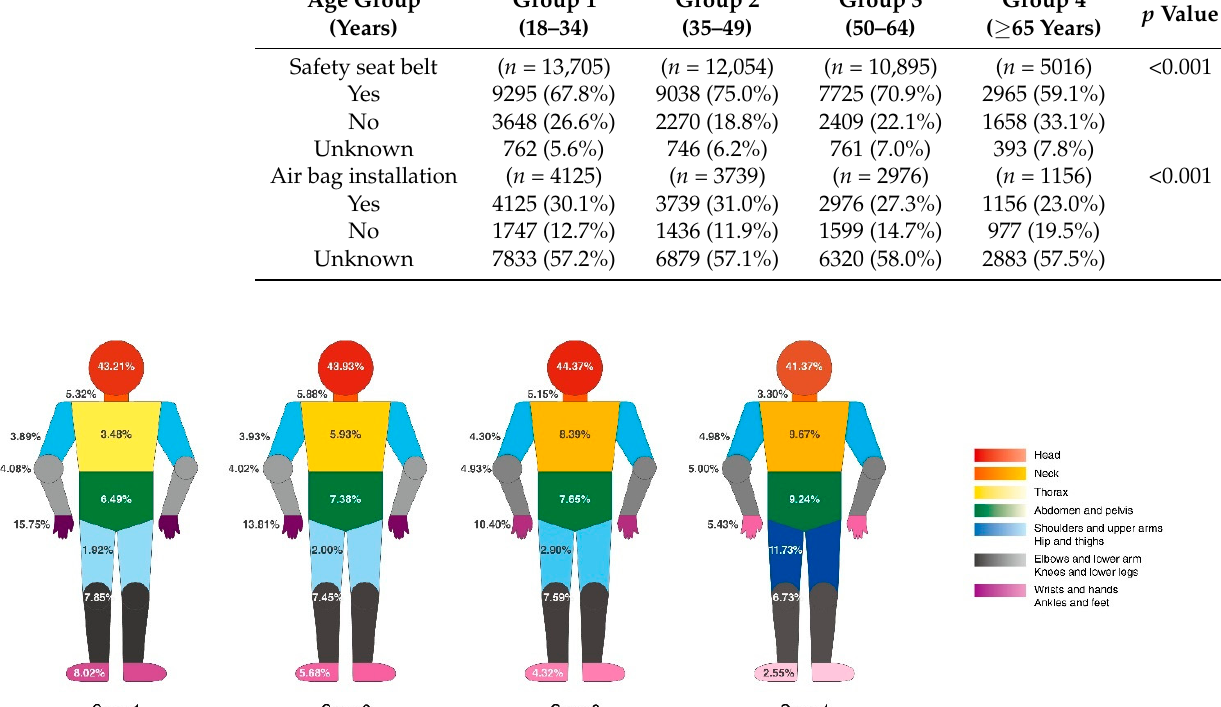
Figure 5. Anatomical sites of the injury according to age group analyzed by International Classification of Disease 10th Revision (ICD-10) codes. Group 1 (18–34 years old), Group 2 (35–49 years old), Group 3 (50–64 years old), Group 4 ( ≥ 65 years), presented respectively from left to right). Body parts are indicated by color. Higher color saturation indicates a higher injury rate.